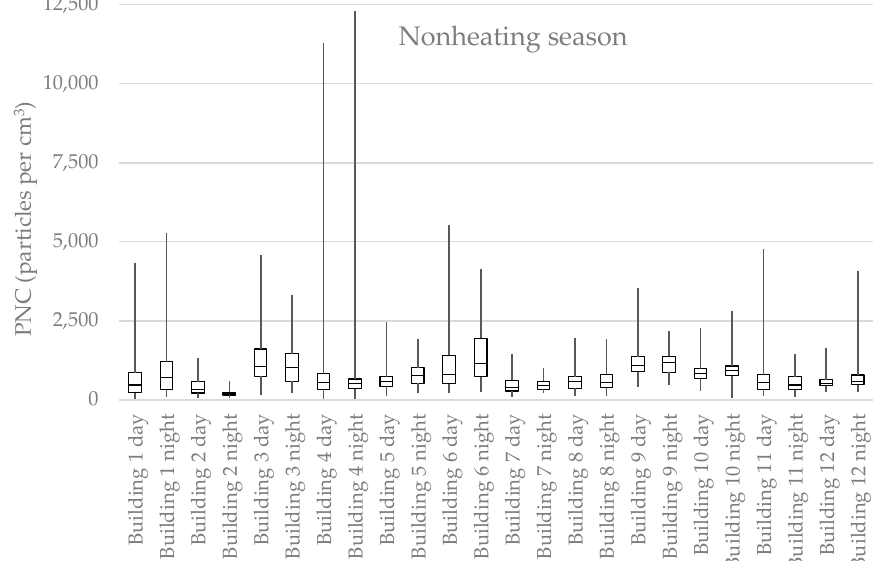
Figure 4. Mean, 25th, and 75th percentile and min and max values for the NP number concentrations in twelve office buildings during daytime (from 6 a.m. until 6 p.m.) and nighttime (from 6 p.m. until 6 a.m.) during a one-week measuring period in the nonheating season. Subsequently, we also calculated the concentration of NPs smaller than 100 nm, also called ultrafine particles (Table 2). In the offices with the highest number concentrations, at least 80–90% of the particles were <100 nm. During the nonheating season, the fraction of particles <100 nm was relatively smaller in comparison with the heating season. The average size of the NPs varied from 37 to 105 nm, being relatively smaller during the heating season (Table 2). Average temperature and average relative humidity during the measurements are presented in Table A1, Appendix A. Table 2. Average concentrations of measured NPs ( ≤ 461 nm), ultrafine particles (<100 nm), and av- erage sizes of NPs in twelve office buildings in Umeå during the heating and nonheating seasons, and the buildings’ distances from a busy street. The buildings and their numbers are presented in Figure 1. Buildings 1–12